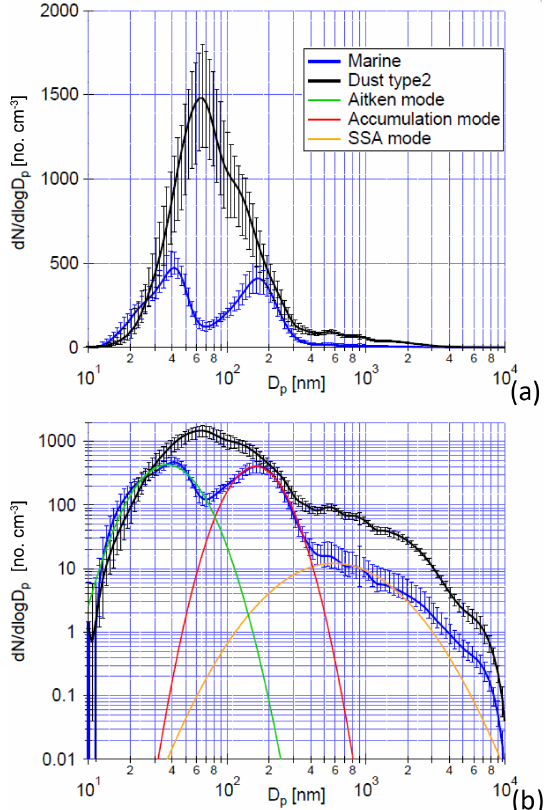
Figure 8. (a) The median of PNSDs of marine type (blue) and dust type (black), with a linear and (b) logarithmic scaling on the y axis, measured from 21 September 03:30:00 to 21 September 20:00:00 (UTC) and from 28 September 09:30:00 to 30 September 18:30:00 (UTC). Panel (b) includes the aerosol size modes that fit the method also used in Modini et al., 2015. The error bar indicates the range between the 25th and 75th percentiles. This figure was adapted from Fig. 5 in Gong et al.